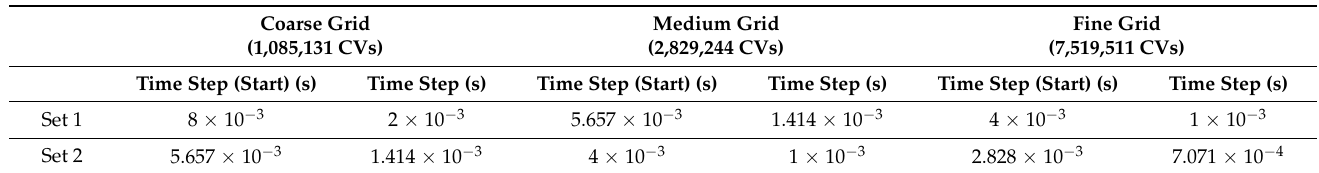
Table 3. Number of cells (CVs) and time steps sizes of grids used to validate the numerical method. Data from [11].